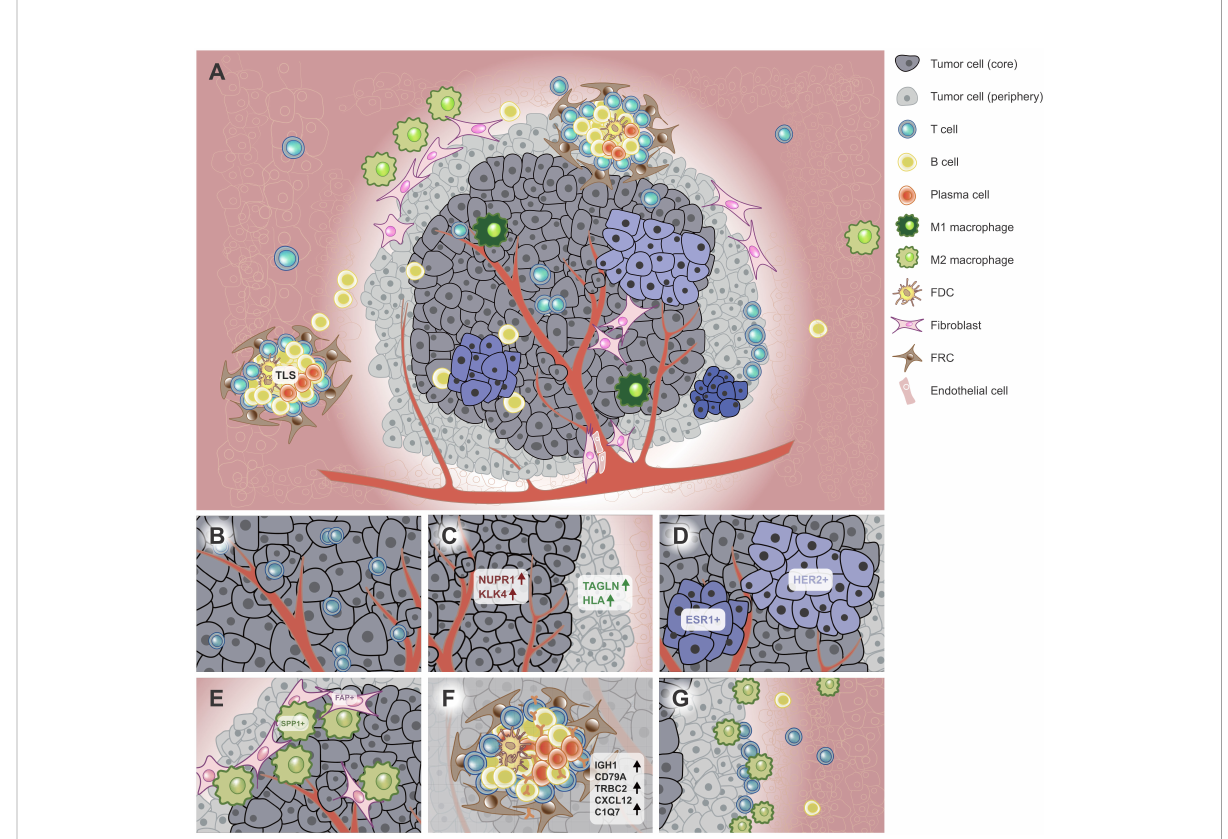
FIGURE 1 Spatial heterogeneity of the tumor. (A) ST techniques have been used to characterize the spatial architecture of tumors. For example, the tumor core (dark grey) and periphery (light grey) have different tumor cell subpopulations (light bule to dark blue). The TLS was found in or near the tumor, which aggregates diverse lymphoid cells. (B) CDH12+ tumor epithelial cells colocalized with exhausted CD8+ T cells in bladder cancer. (C) The tumor core and periphery had different signature genes in PC. (D) HER2 + and ESR1 + breast tumor subclones had mutually exclusive localizations in BC. (E) Tumor-speci fi c FAP + fi broblasts and SPP1 + macrophages colocalized in the CRC tissue. (F) TLSs have speci fi c cell composition and signature genes. (G) The tumor interface has unique TME. Immune cells such as macrophages and NK/T cells were recruited to the interface and the region nearer to the interface enriched more immune cells in ICC. FDC, follicular dendritic cell; FRC, follicular reticular cell. PC, prostatic cancer. CRC, colorectal cancer. TME, tumor microenvironment. ICC, intrahepatic cholangiocarcinoma. BC, breast cancer. TLS, tertiary lymphoid